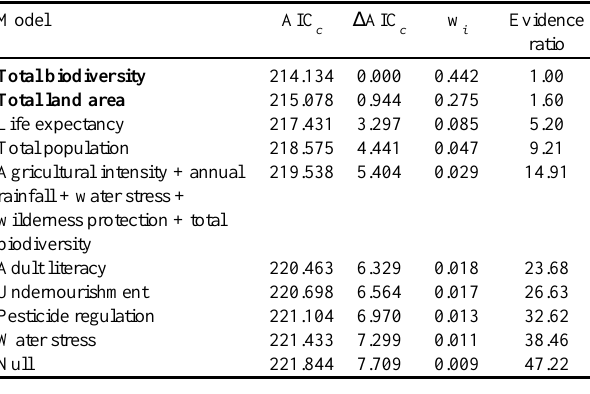
Table 1 . A comparison of support for the top 10 models of social-ecological factors and the proportion of endangered birds in 100 different countries. Models were ranked by and